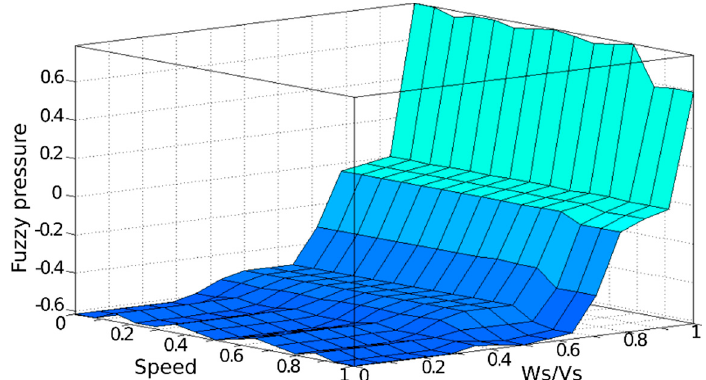
Figure9. Graphshowingthedependenceofoutputvariableontheinputvariablesinthefuzzycontroller. Figure 9. Graph showing the dependence of output variable on the input variables in the fuzzy controller.